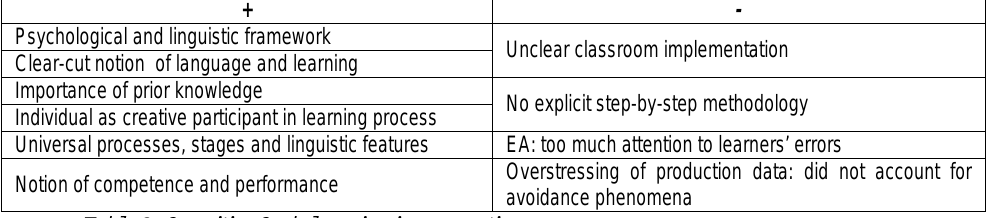
Table 3: Cognitive Code learning in